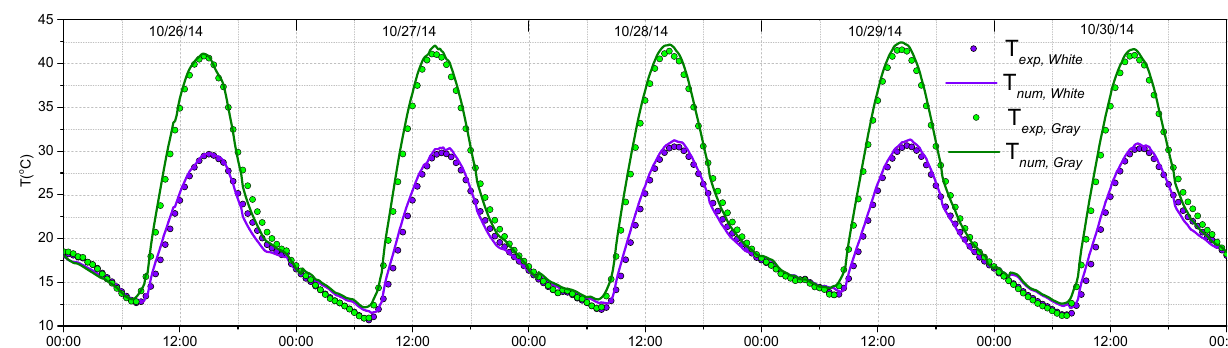
Figure 3. Comparison of the experimental data from Hernández-Pérez et al. [22] and the data obtained with the numerical model.